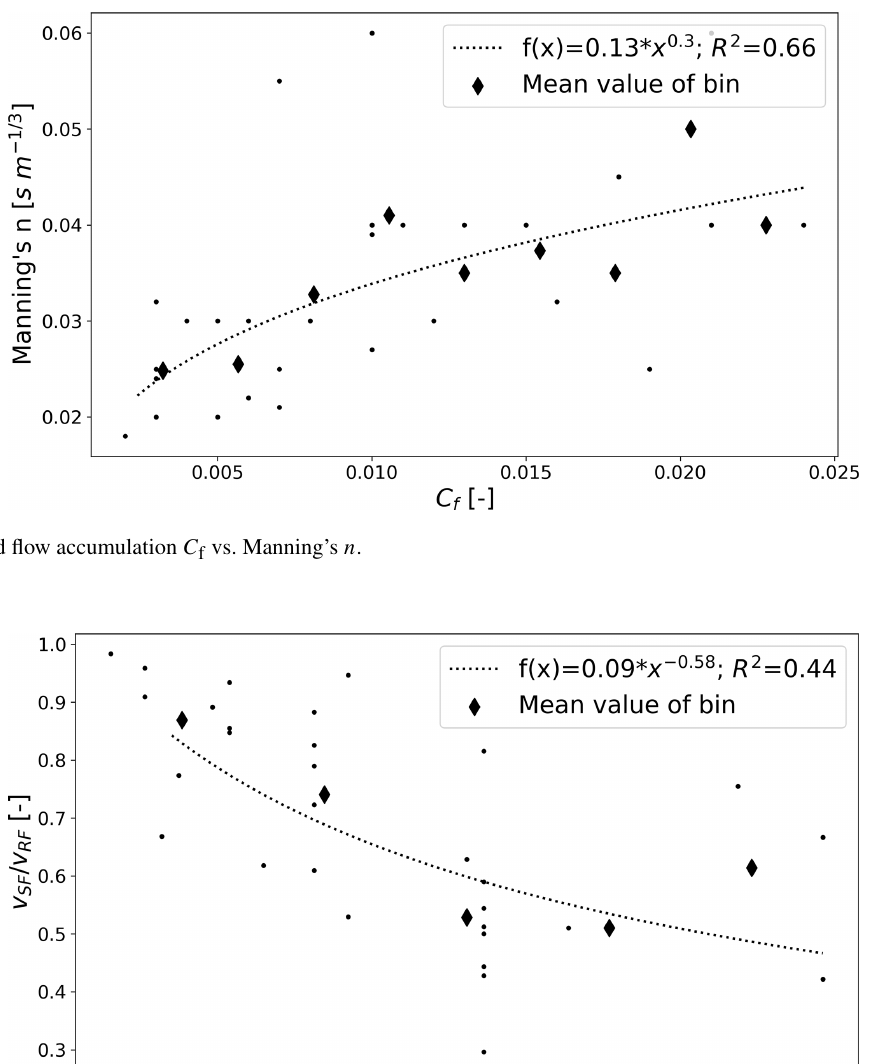
Hydrol. Earth Syst. Sci., 26, 3125–3150, 2022